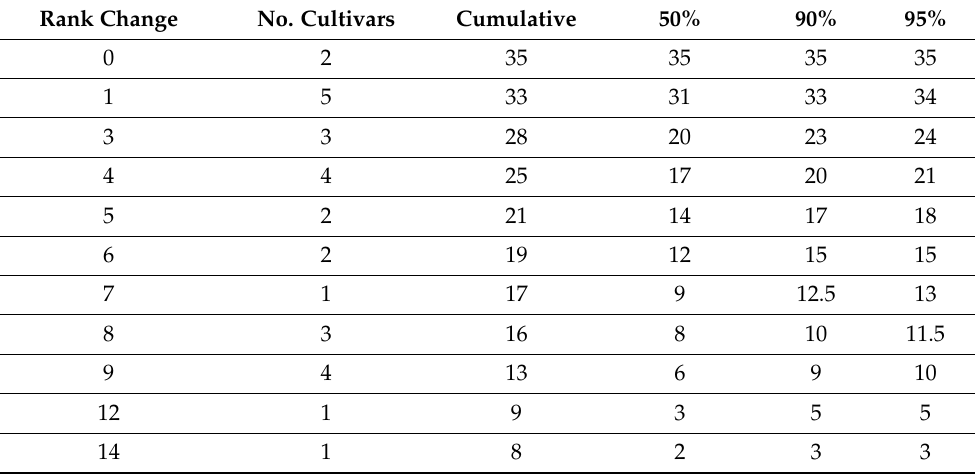
Table 13. Absolute yield rank differences for the 2012 trial. Number of cultivars shows the number of cultivars with the given rank change and Cumulative shows the number with that rank change or greater. The 50%, 90% and 95% points are from the simulated variables and show the distribution of the number of cultivars that exhibited an absolute rank change at least as large as that specified due to random variation, as described in the text. Rank Change No. Cultivars Cumulative